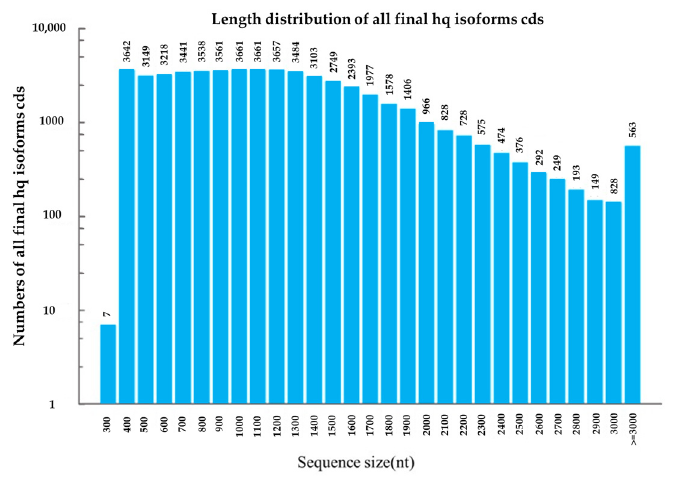
Figure 3. CDS length distribution. Note: X axis represents the length of CDSs. Y axis represents the number of CDSs.